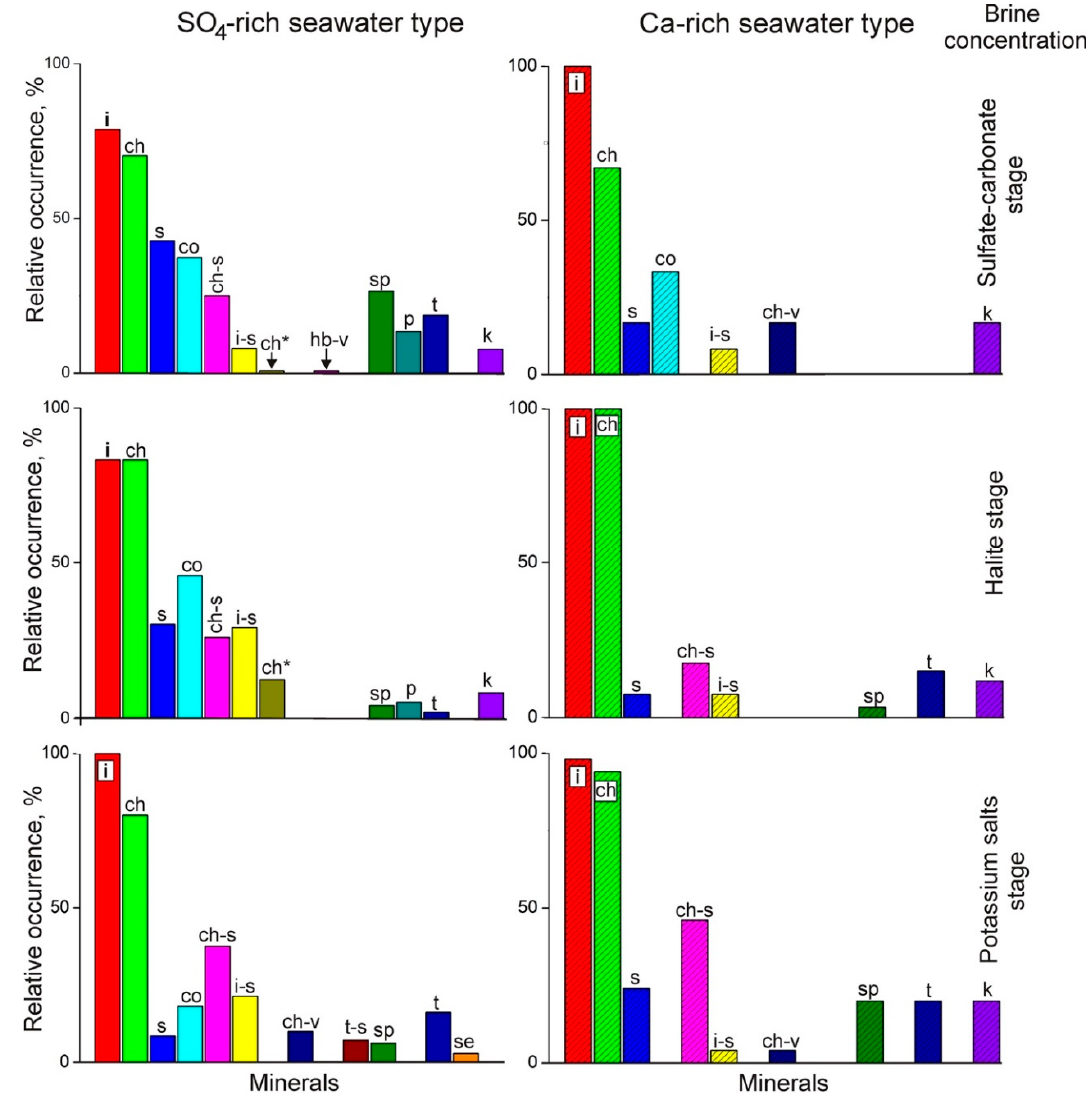
Figure 5. Relative occurrence of clay minerals of Phanerozoic evaporite formations deposited from seawater of SO 4 -rich and Ca-rich chemical types. Minerals: illite (i), chlorite (ch), smectite (s), corrensite (co), chlorite-smectite (ch-s), illite-smectite (i-s), swelling chlorite (ch*),chlorite-vermiculite (ch-v), hydrobiotite-vermiculite (hb-v), talc-smectite (t-s), sepiolite (sp), palygorskite (p), talc (t), serpentine (se), kaolinite (k).